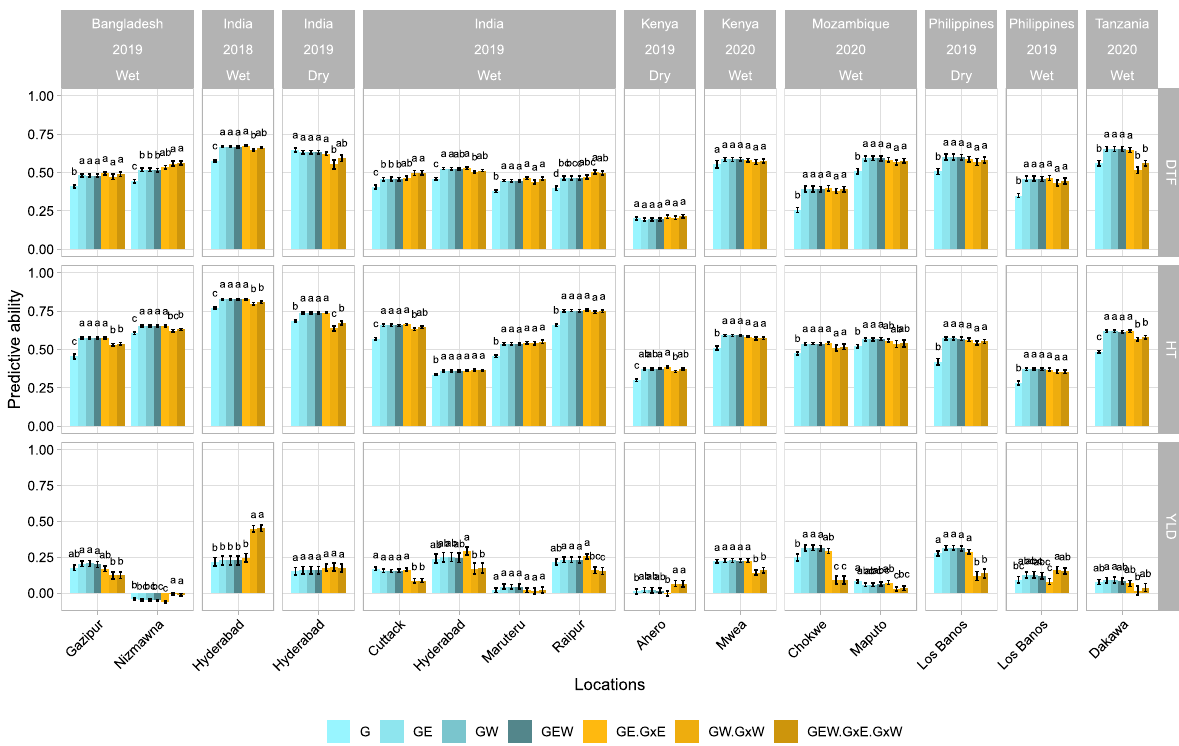
Fig. 5 Predictive abilities for untested environments using the CV‑RAN scenario. Seven different models are compared (see material and methods section). The letters at the top of each bar represent the results of Tukey’s HSD comparison between models in each environment. The means between two groups are significantly different ( p ‑value < 0.05) if there is no letter in common. The error bars are presented by PA mean SE is the standard error of PA values from 50 replicates. DTF days to flowering; HT plant height; YLD grain